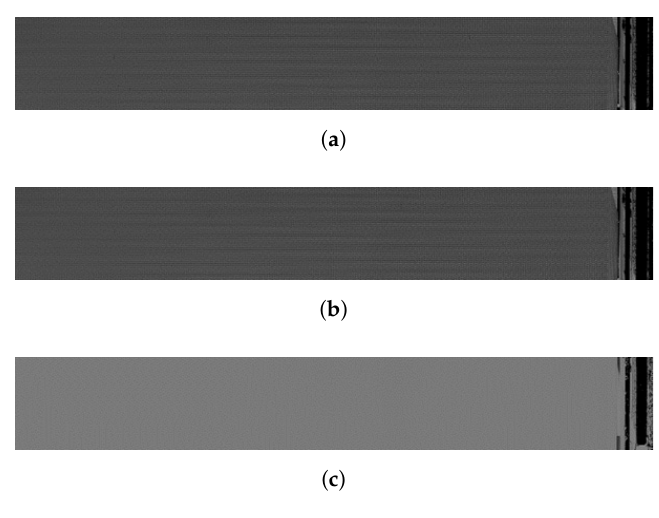
Figure 7. Scanning images (8192 × 1024) of an AMOLED panel ( a ) by simplex search method (SSM) with Tenenbaum ( b ) by equal search with Tenenbaum and ( c ) equal search with variance.